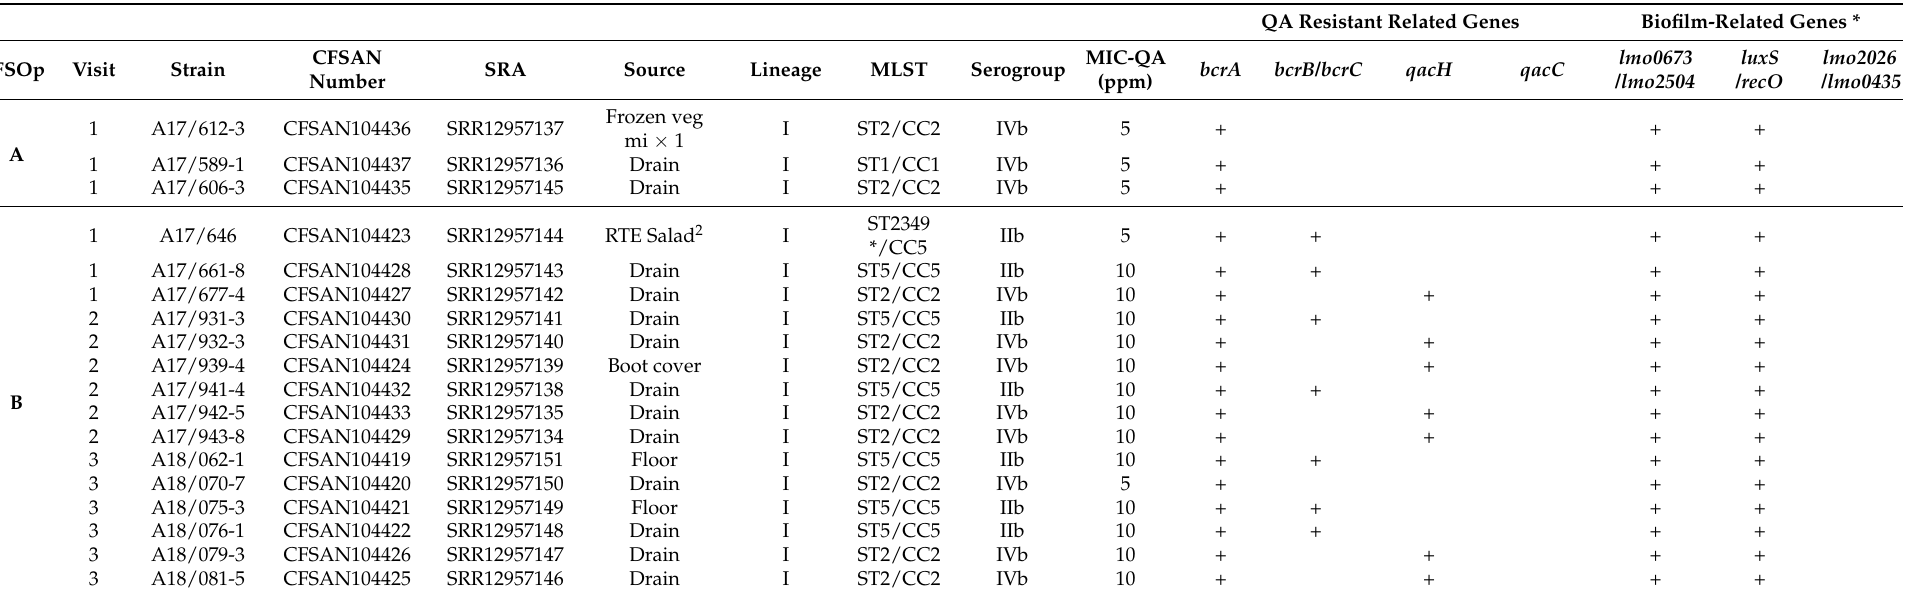
Table 5. L. monocytogenes genomic characterization and MIC-QA